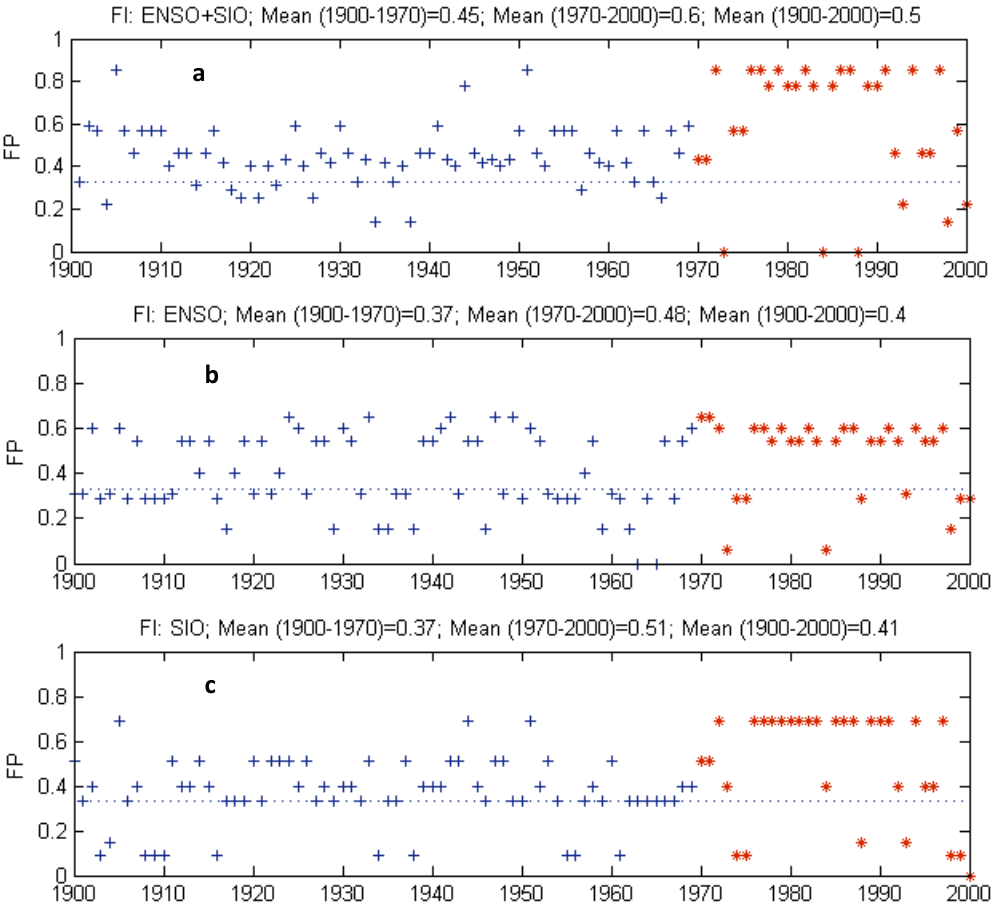
Figure 8. Time series of the forecast probability using different indices: (a) ENSO and SIO together, (b) ENSO, and (c) SIO. The period (1900–1970) is used for calculating the probabilities (shown in crosses) using Eq. (2) and 1970–2000 for validation (shown in stars).